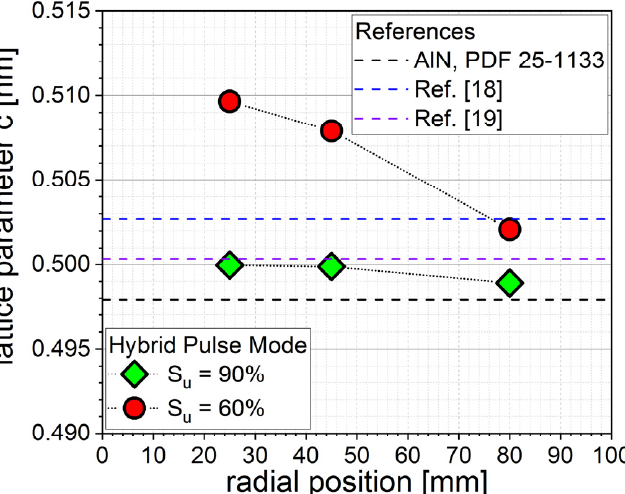
Figure 4. Calculated c-lattice parameter of 0.9 µm films deposited with different hybrid pulse modes depending on radial position (PDF 25-1133; theoretical AlN lattice parameter c = 0.49792 nm, as well as calculated values for Al 0.7 Sc 0.3 N from [18,19] for comparison).